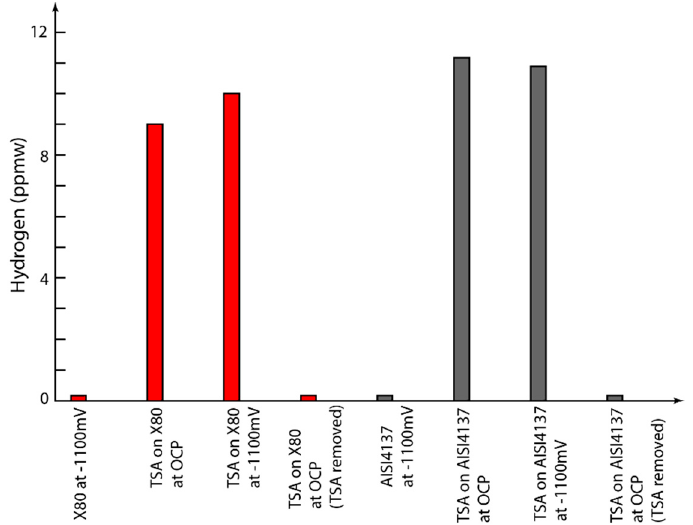
Figure 14. Hydrogen content in specimens after a 30-day exposure to ASTM D1141 synthetic seawater. TSA coatings from two specimens were removed just before hydrogen measurement.